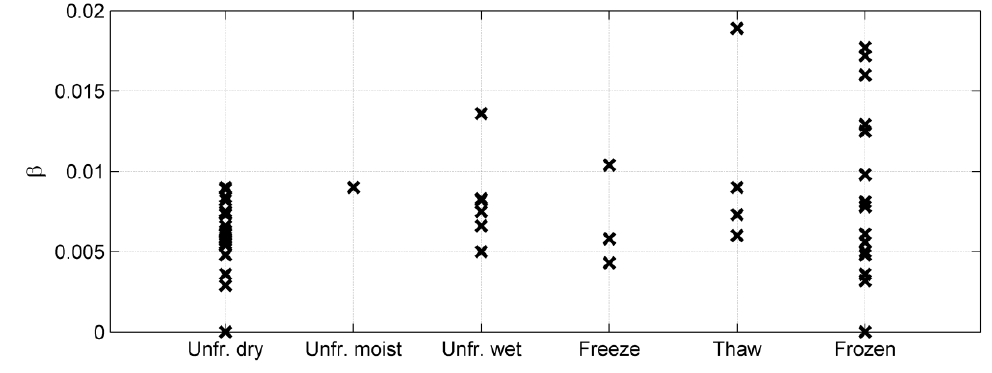
Figure 5. Estimates of the model parameter β at Krycklan with respect to environmental conditions for PALSAR data acquired with 34.3° look angle and HH-polarization. “ Unfr. ” refers to unfrozen conditions. Frozen conditions refer to images acquired under dry conditions as well as cases with snow fall. If precipitation was recorded at <2 mm, the unfrozen conditions were moist; otherwise, the conditions were